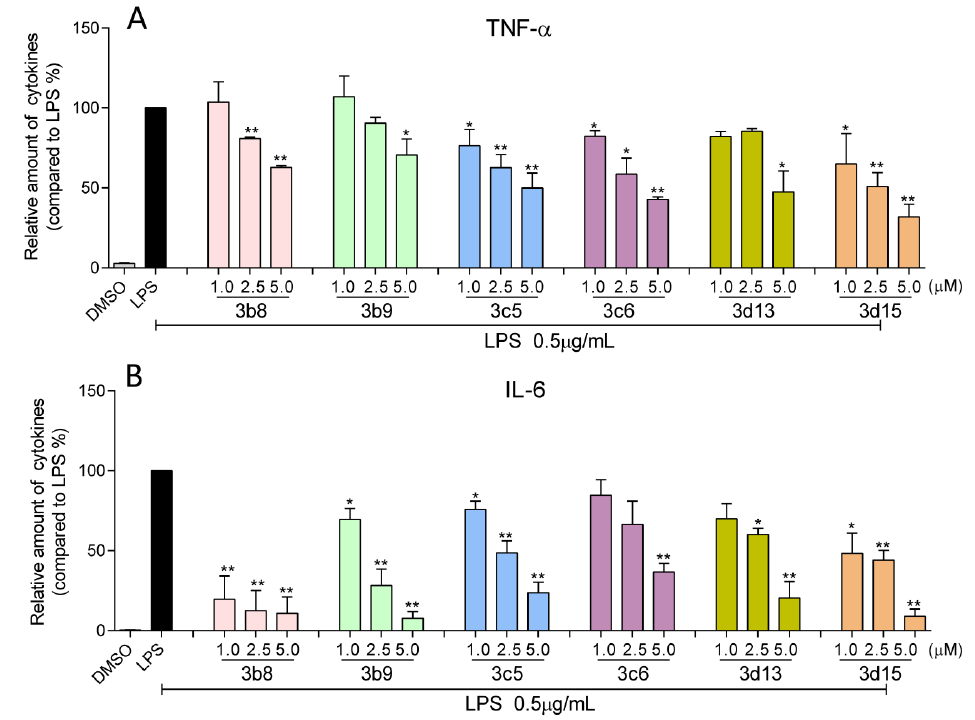
Figure 3. Effects of active compounds on TNF- α ( A ) and IL-6 ( B ) production at dose-dependent manner. Macrophages were treated with vehicle (DMSO) or various concentrations of active compounds for 2 h, then incubated with or without LPS (0.5 µg/mL) for 22 h. TNF- α and IL-6 levels in the culture media were measured by ELISA and were normalized by the total protein. Values represent the mean ± SEM for three independent experiments and LPS is regarded as 100%. Statistical significance relative to LPS was indicated, * p < 0.05; ** p <